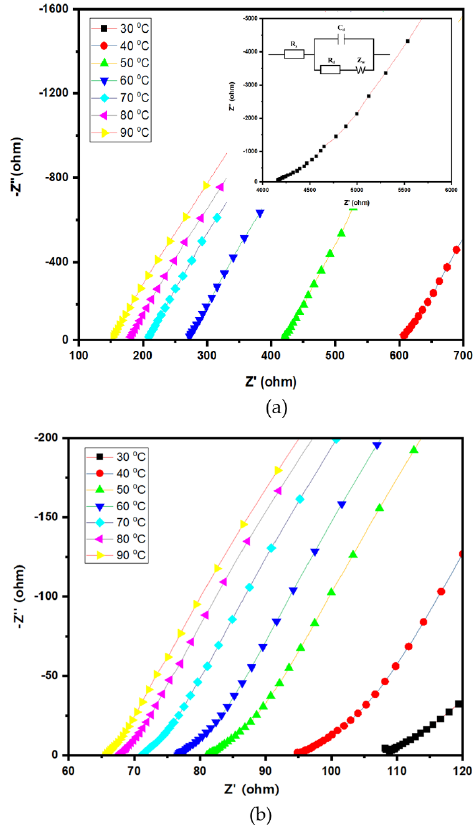
Figure 8. Nyquist plots of ( a ) SGPE30 and ( b )